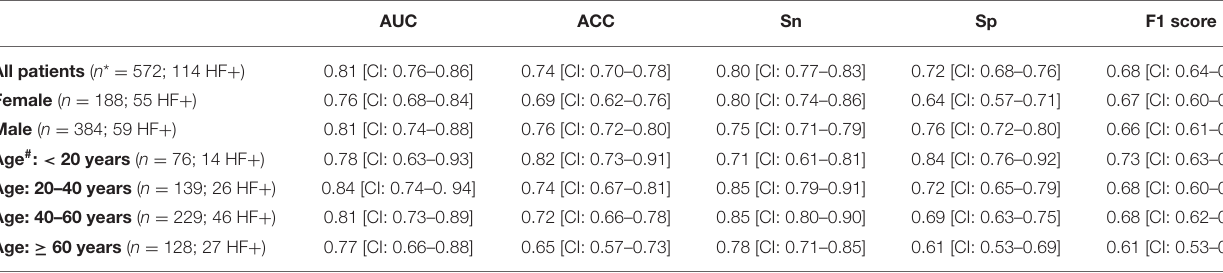
* n represents number of patients (of 572 patients in the testing subset). # Age at diagnosis of hypertrophic cardiomyopathy. HF + , positive heart failure outcomes; CI: 95% confidence interval; AUC, area under receiver operating characteristic curve; ACC, accuracy; Sn, sensitivity; Sp, specificity.